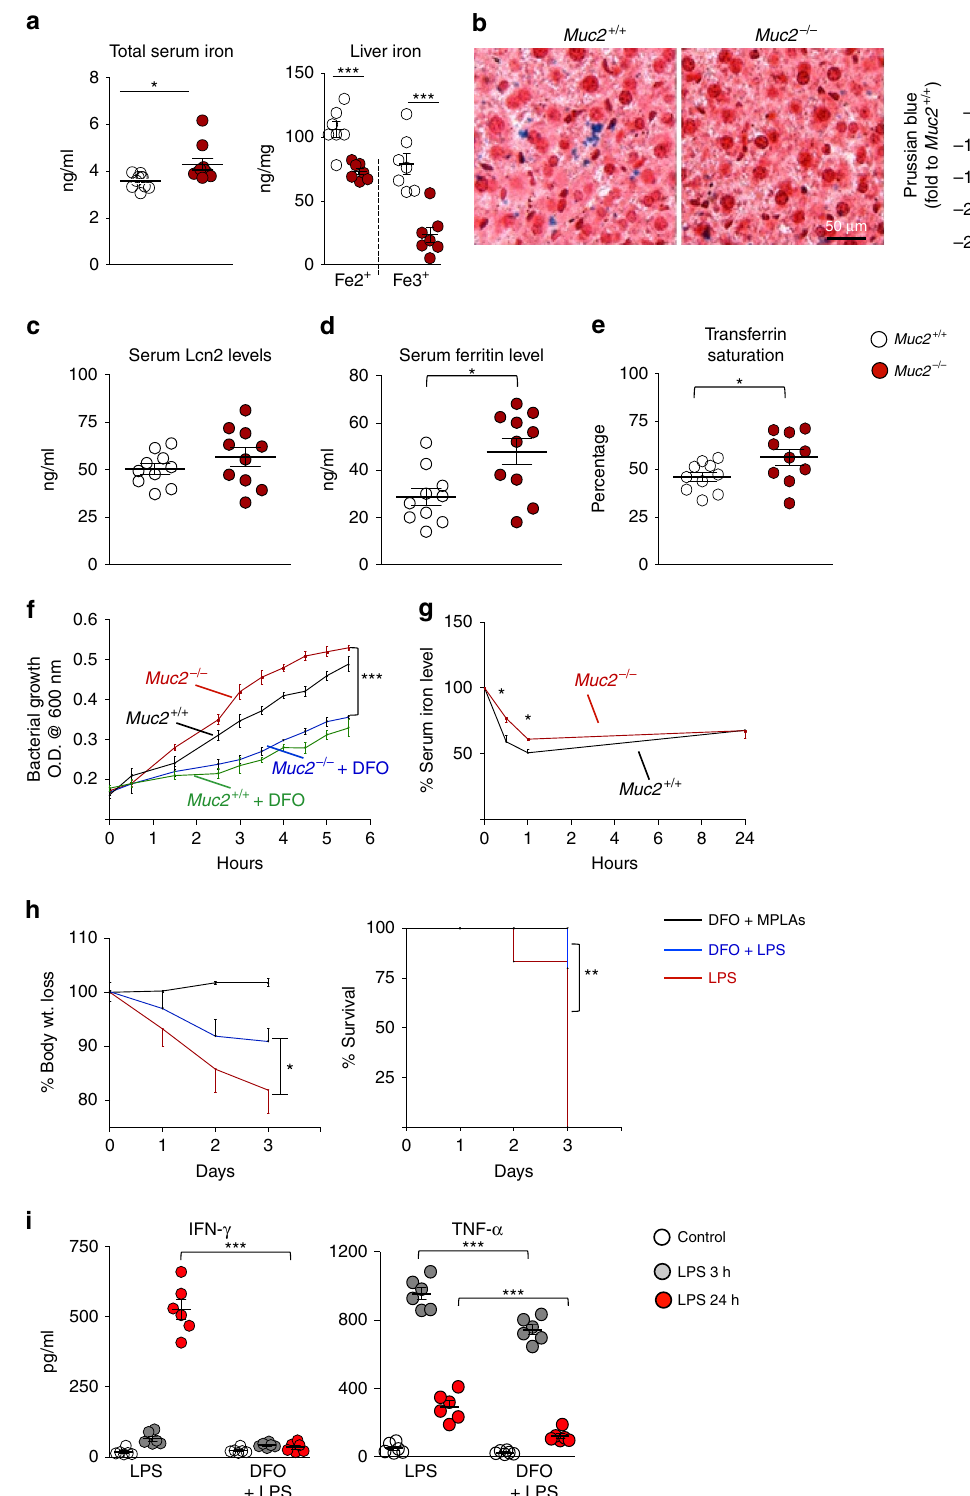
the duodenum, splenocytes, and liver of Muc2 − / − and Muc2 + / + (Supplementary Fig. 3D) suggesting similar ef fi ciency in iron absorption by both genotypes 31 . We next investigated the levels of serum lipocalin2 as they are known to alleviate iron over-load and disposal of iron from the host 32 and found comparable levels in the circulation of both genotypes (Fig. 4c). To further investigate iron dysregulation in Muc2 − / − , we quanti fi ed serum ferritin and